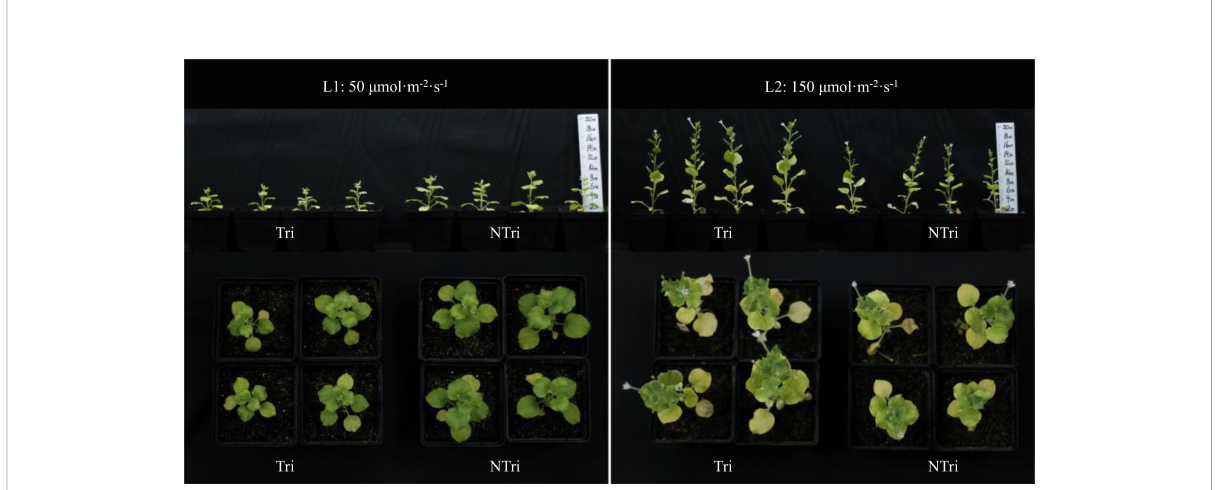
FIGURE 1 Comparison of the N. benthamiana growth under different light conditions with and without Trichoderma inoculation. L1 and L2 denote the two light intensities; Tri and NTri denote the treatment groups inoculated and not inoculated with Trichoderma ,